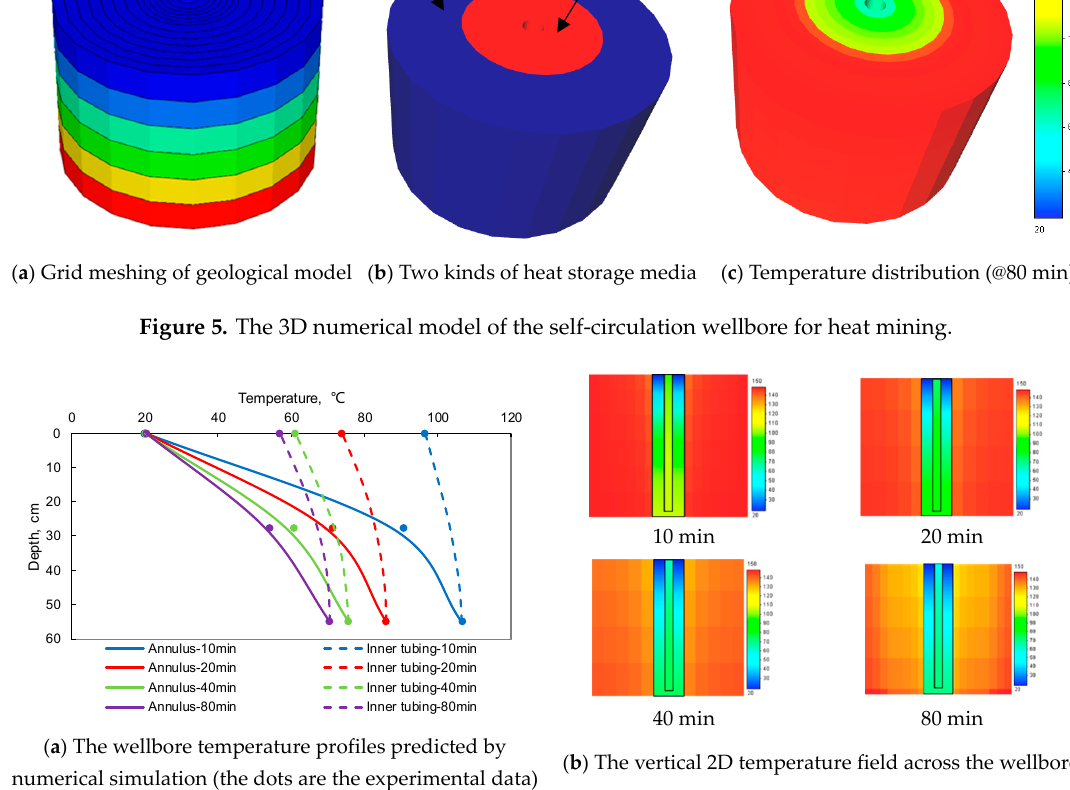
Figure 6. Temperature distributions in the wellbore at different times.